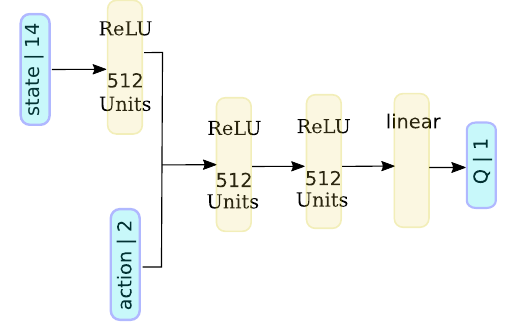
Figure 2. Layout of the critic network for DDPG. The networks has three fully connected layers with 512 neurons each with ReLU activation. The states are fed through the network from the first layer while the actions only from the second one. The output layer has linear activation function and outputs the estimated Q-value given the current state and the action